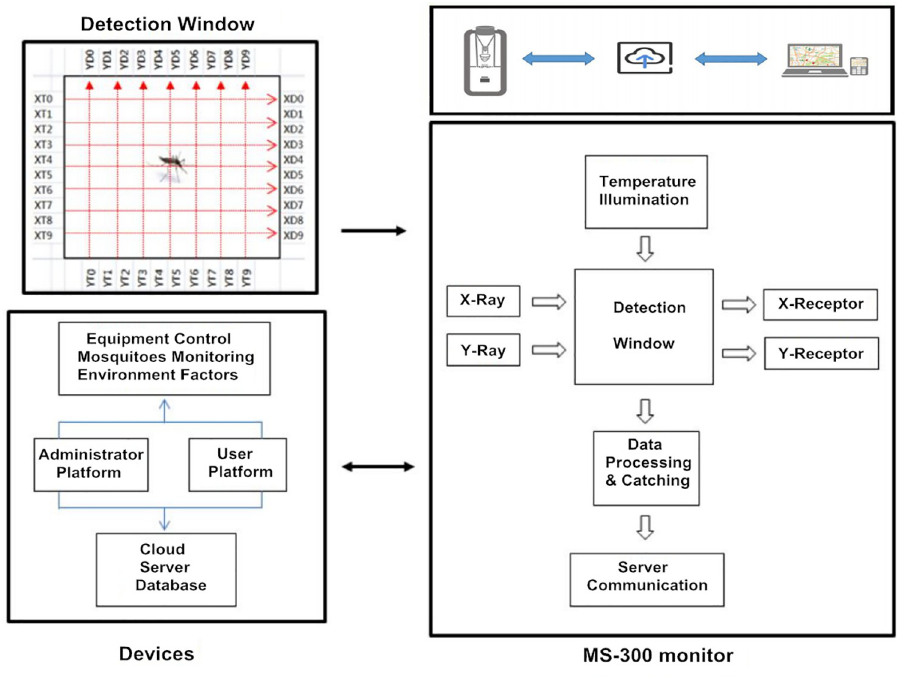
Fig 1. Schematic diagram of the detection and data transmission modules of MS-300. The MS-300 monitor contains an infrared detection window and automatic counting device. An environmental sensor monitors and records the environmental factors such as temperature and illumination. Data processing hardware and software in the monitor perform an analysis and real-time data are transmitted automatically to cloud-based server services and remote